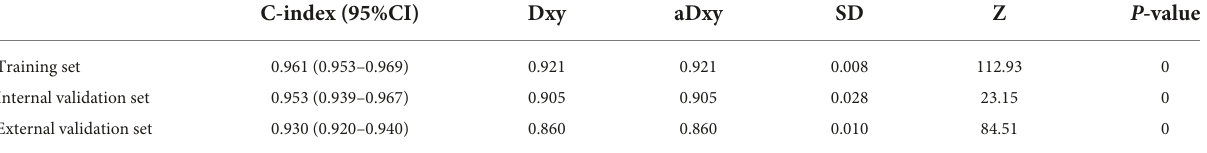
TABLE 5 C-index in the study